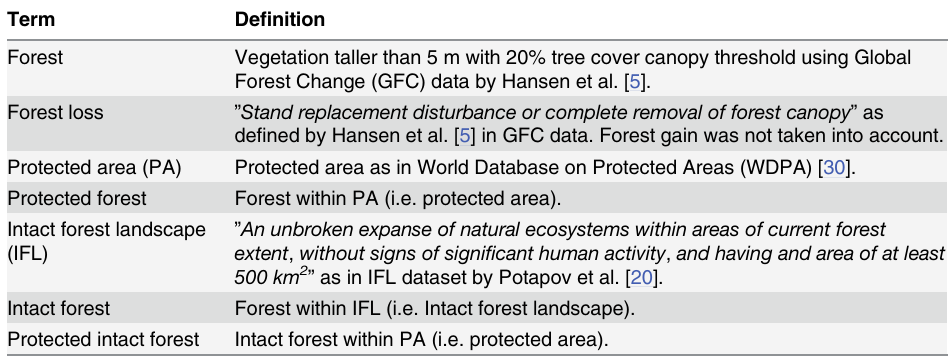
Table 1. Key terminology used in the